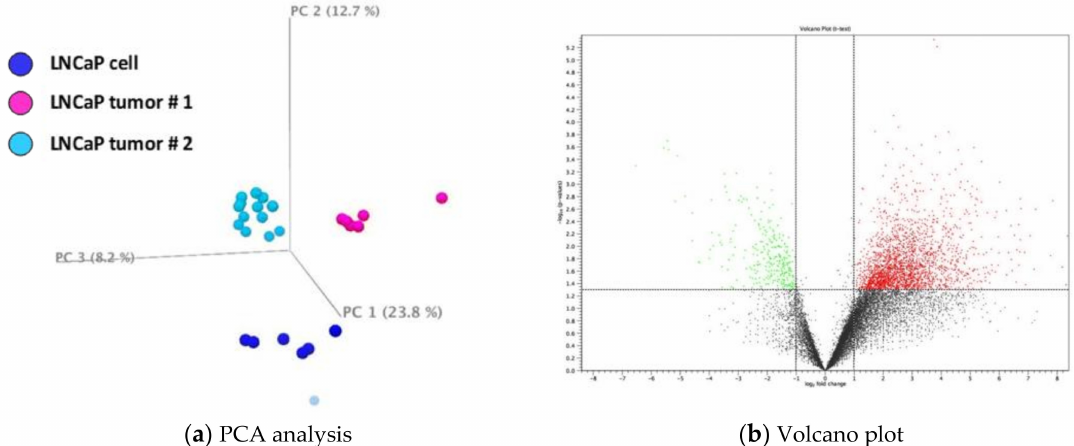
Figure 1. ( a ) Principal component analysis (PCA) and volcano plot of gene expression data comparison. A. PCA of xenograft tumor (n = 6 for each experiment) as compared to LNCaP cells (n = 6). Sets of tumor samples are colored in cyan (#1) and light blue (#2) and cultured cell samples are colored in dark blue. ( b ) Volcano plot of transcript profiles in xenograft tumor as compared to LNCaP cells. Transcriptome profiles with z-score less than − 2 are marked in green and with z-score greater than 2 marked in